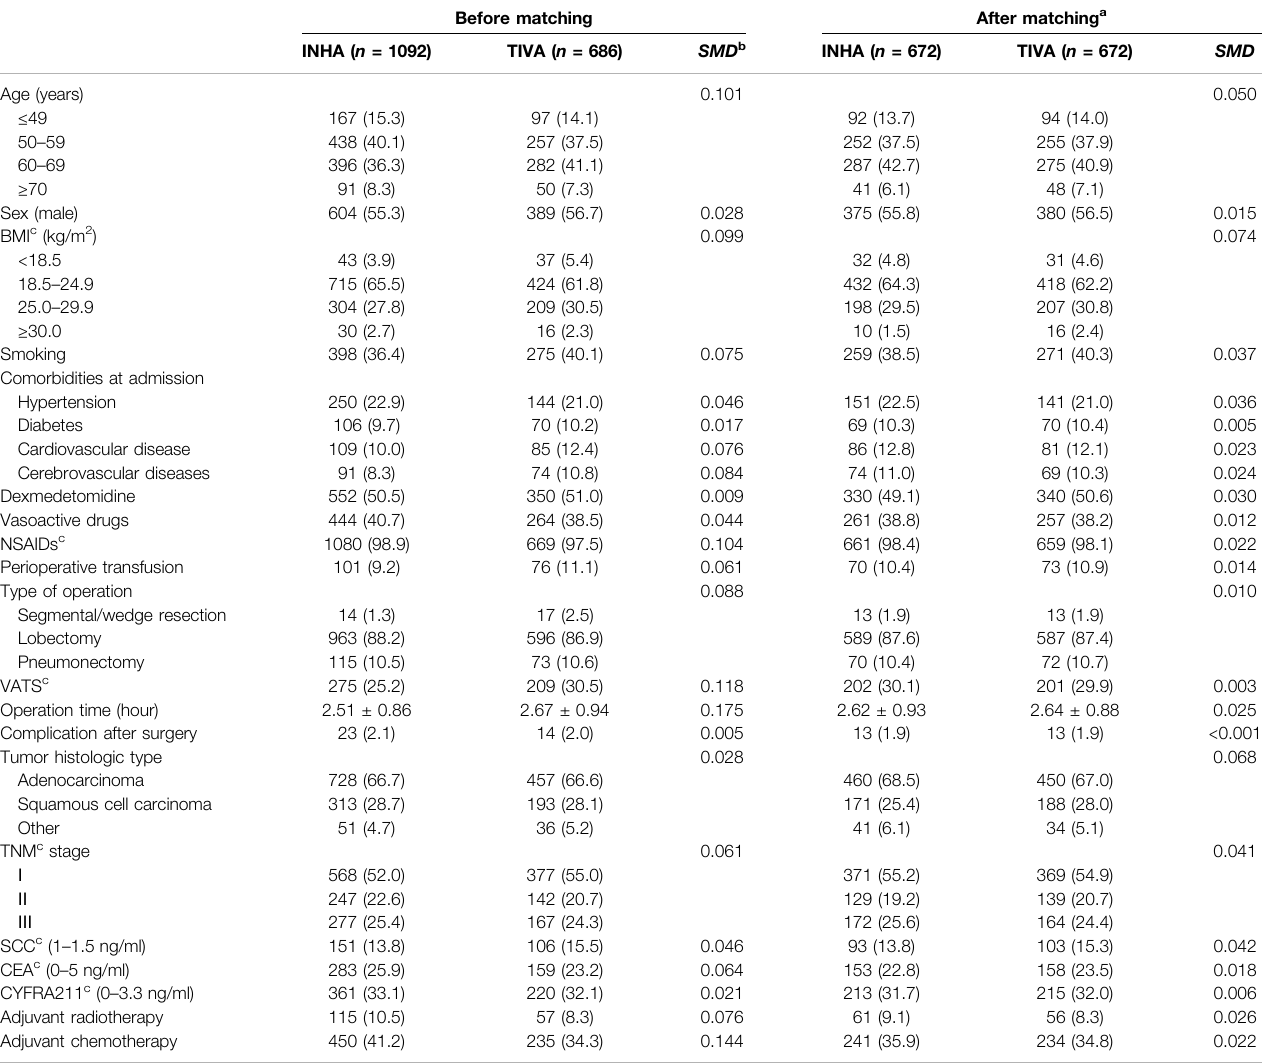
TABLE 1 | Patient characteristics before and after matching. Before matching After matching